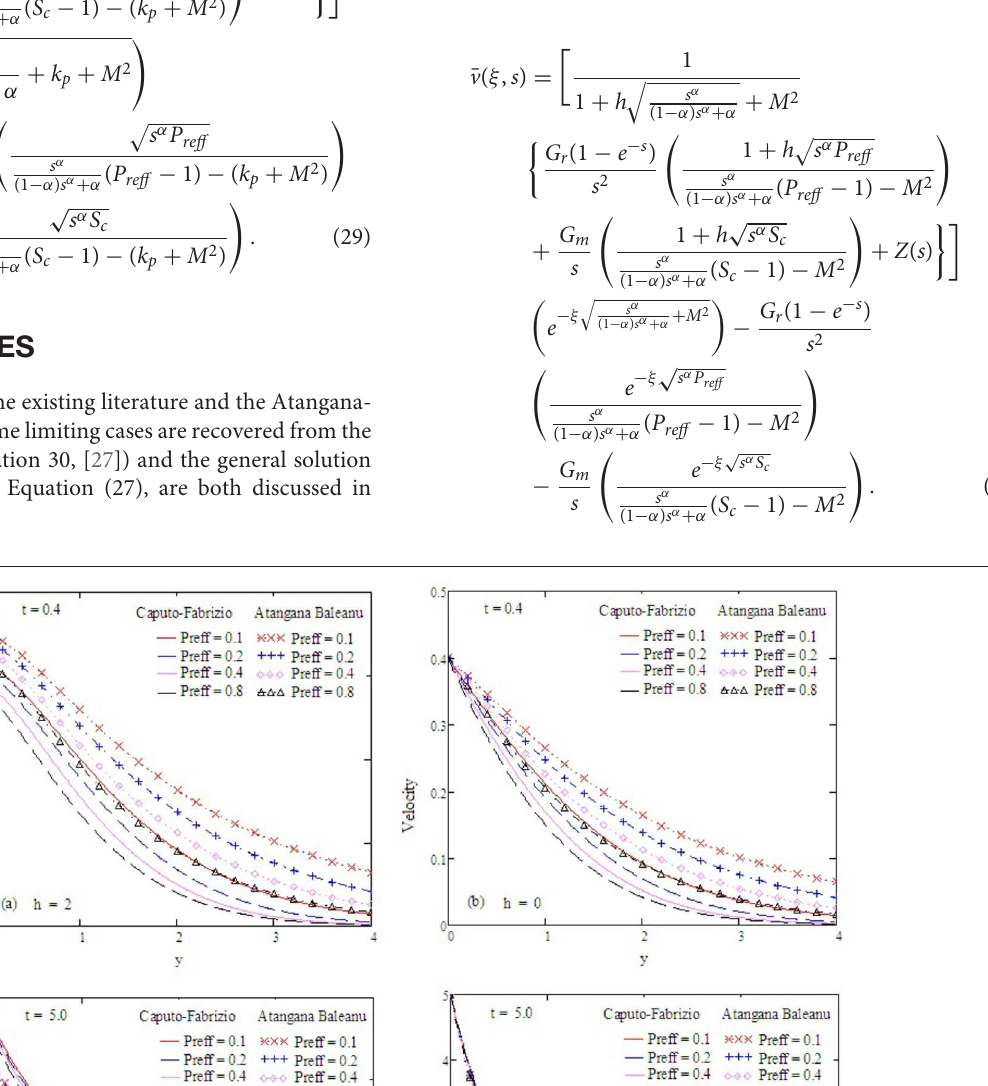
0.5, G r 2, M 0.9, G m 0.75, k p 1.5, and S c = = = = =